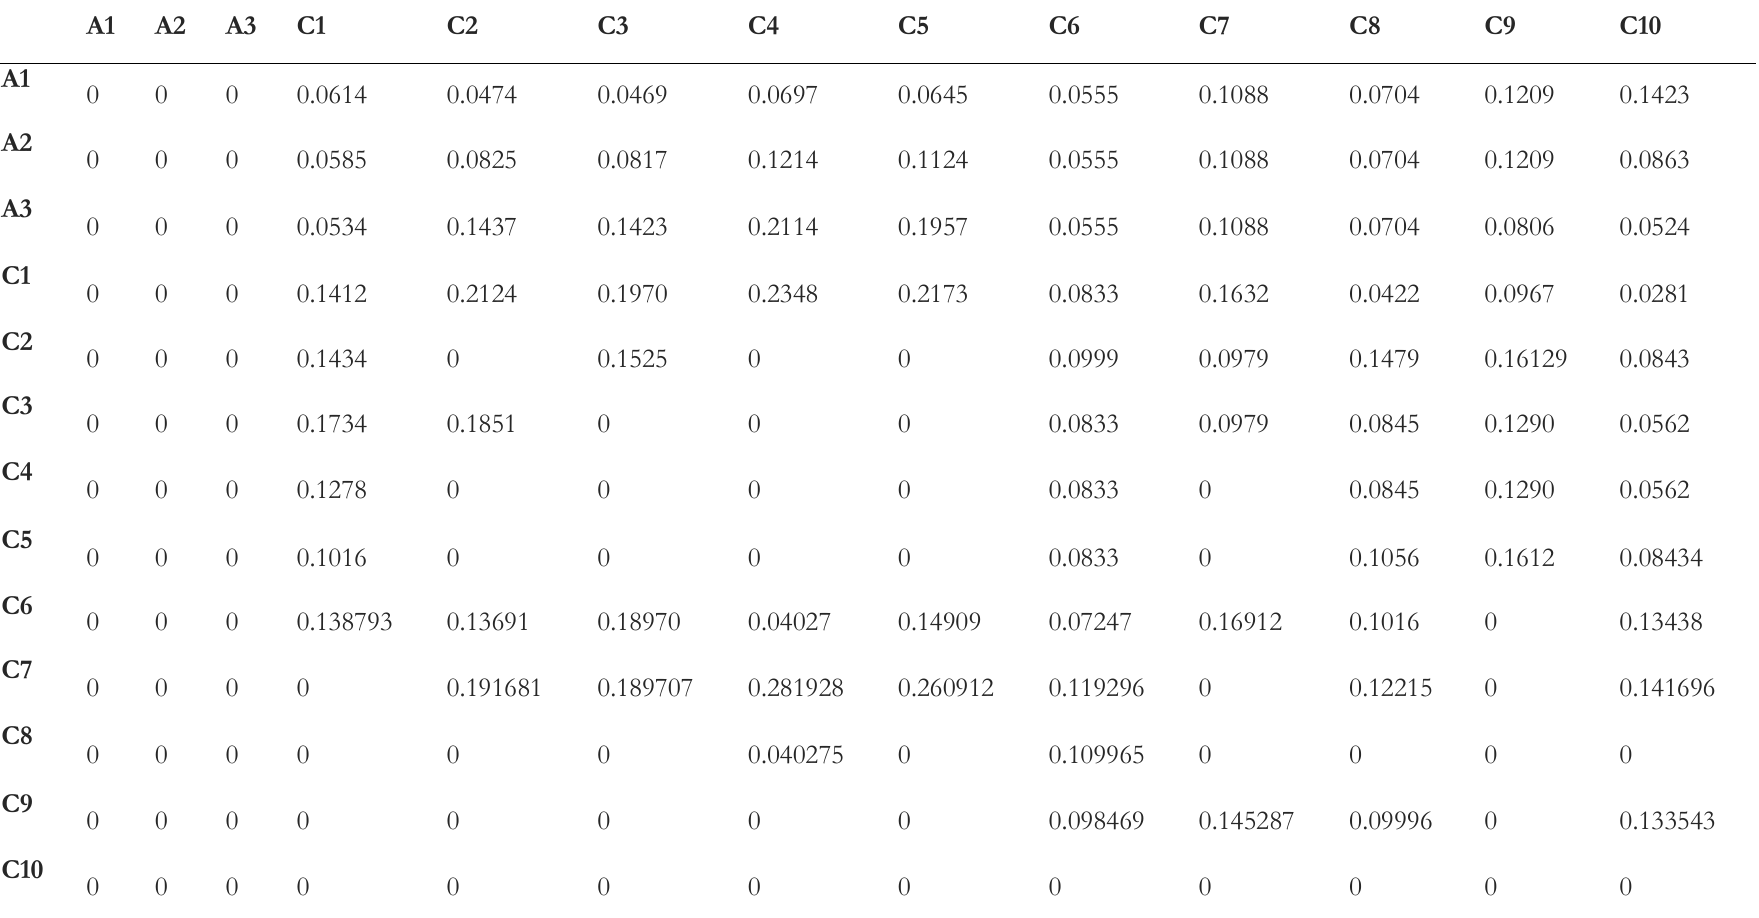
Table 11. Weighted supermatrix respecting the